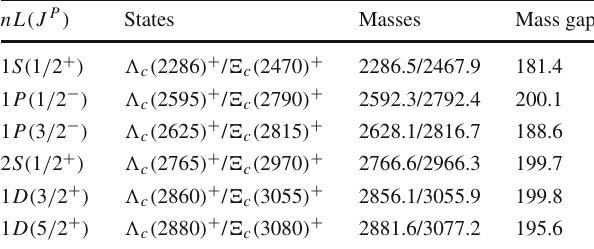
Table 1 The measured masses of 1 S , 2 S , 1 P , 1 D (cid:9) + c and (cid:3) + c baryons [60] and the mass gaps of corresponding states (in MeV)